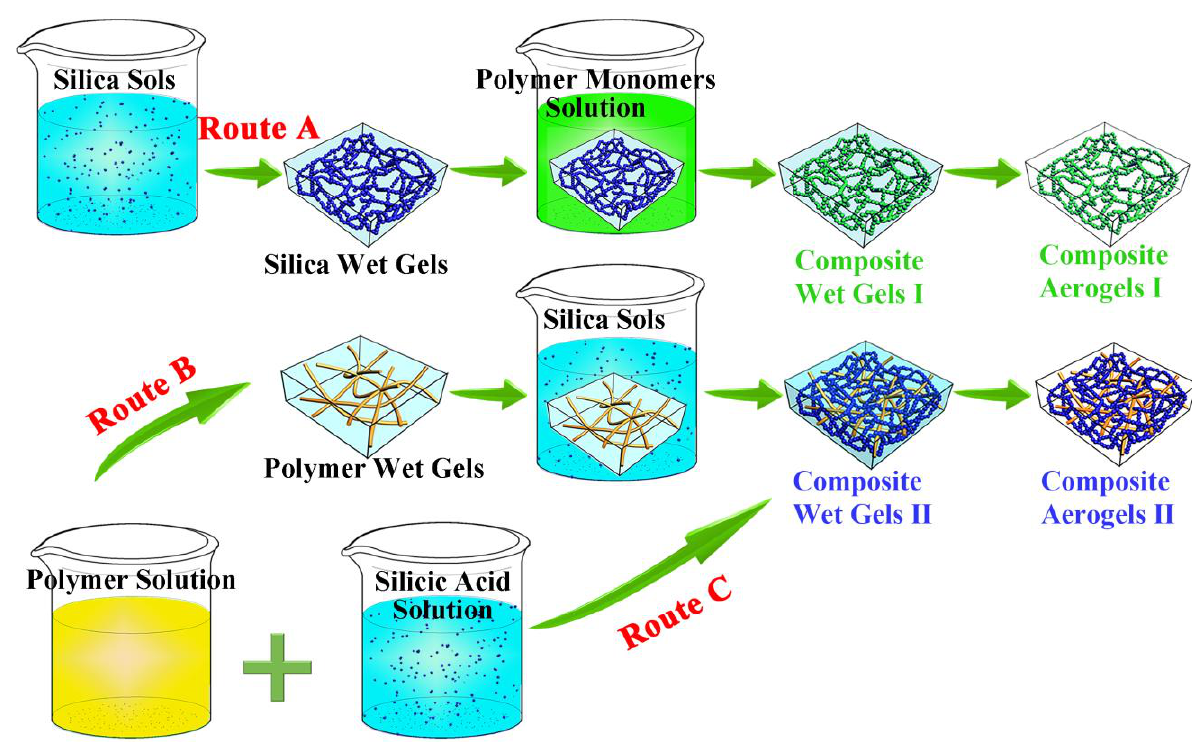
Figure 1. Schematic of the preparation process for composite aerogels via three different routes.